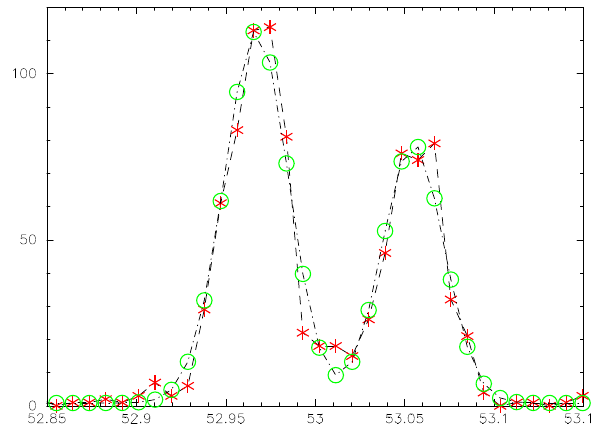
Figure 4. An example of the mass 53 spectral lines in a RM spec- trum CS_45D_20110309T074148_SP_P.TAB. The model fit here is a two-Gaussian model and a constant background. The observed line is shown with the red stars and the fit with green circles. The masses derived are 52.967 and 53.055 u . The masses suggest a sys- tematic error of + 0.022 u in mass and an identification of 53 Cr + at 52.9401 u and C 4 H + at mass 53.0386 u 5